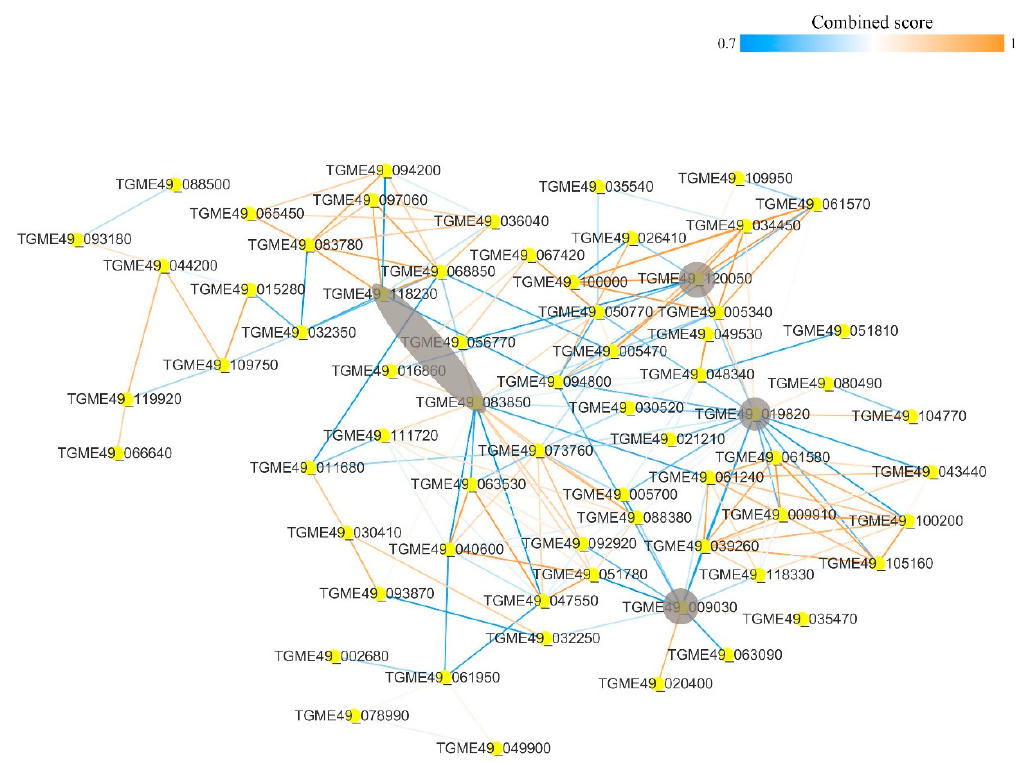
Figure 11. Protein–protein interaction network of the acetylated proteins in PRU strain. Nodes represent the acetylated proteins and edges represent interactors between acetylated proteins. The color of the edges denotes the combined score of interactors. The grey color indicates the major/hub nodes of the protein-protein interaction network.